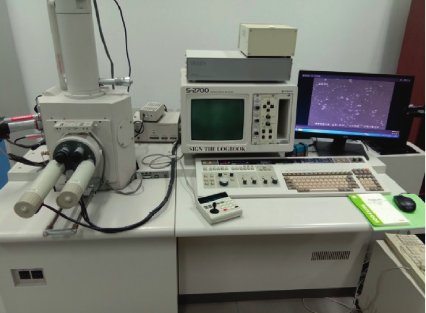
Figure 9: HITACHI S-2700 scanning electron